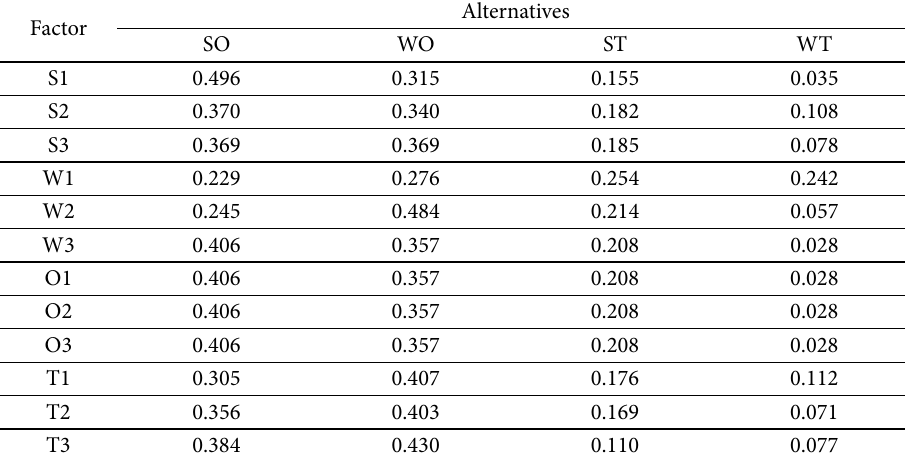
Table 13. The weights of the alternatives under each criterion Factor